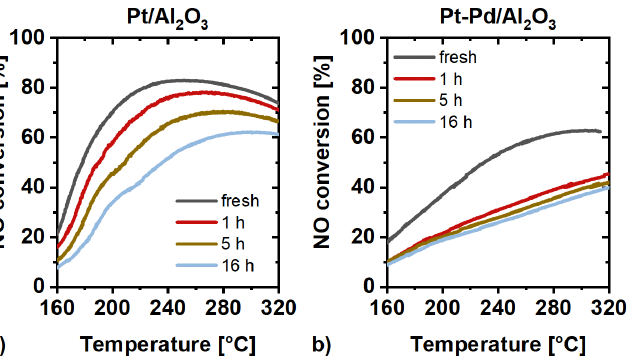
Figure 6. Catalytic activity for CO conversion of reduced Pt/Al 2 O 3 ( a ), Pd/Al 2 O 3 ( b ), and Pt- Pd/Al 2 O 3 ( c ) during a light-off test in 800 ppm CO, 7% CO 2 , 5% O 2 , 5% H 2 O, and bal. N 2 at a gas hourly space velocity (GHSV) of 80,000 h − 1 .